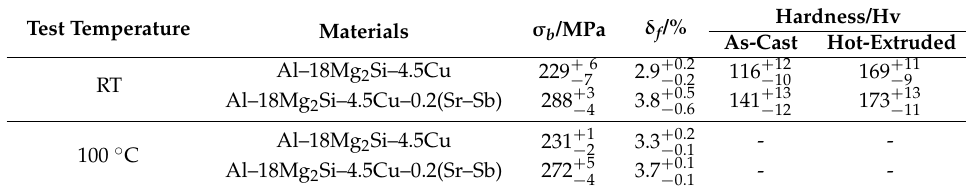
Figure 5. Engineering stress–stain curves of hot-extruded and T6 treated alloys: ( a ) Al–18Mg 2 Si–4.5Cu tensile at room temperature; ( b ) Al–18Mg 2 Si–4.5Cu–0.2(Sr–Sb) tensile at room temperature; ( c ) Al–18Mg 2 Si–4.5Cu tensile at 100 °C; ( d ) Al–18Mg 2 Si–4.5Cu–0.2(Sr–Sb) tensile at 100 °C. Table 1. The mechanical properties of hot-extruded and T6 treated Al–18Mg 2 Si–4.5Cu alloys with and without 0.2 wt % Sr–Sb addition tested at room temperature and at 100 ˝